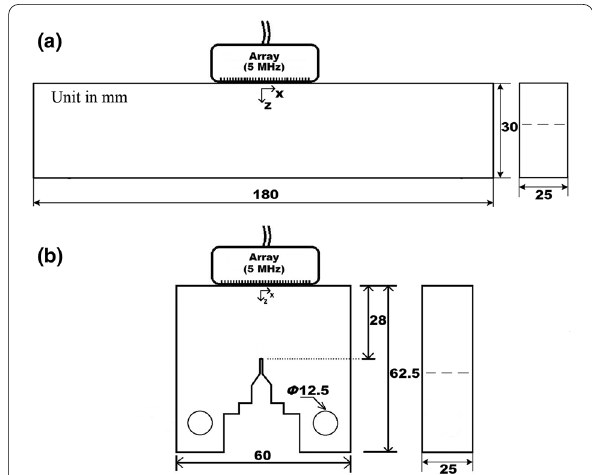
Figure 2 Schematic diagram of experimental configuration on ( a ) an undamaged aluminium specimen and ( b ) an undamaged steel specimen (dimensions in mm)